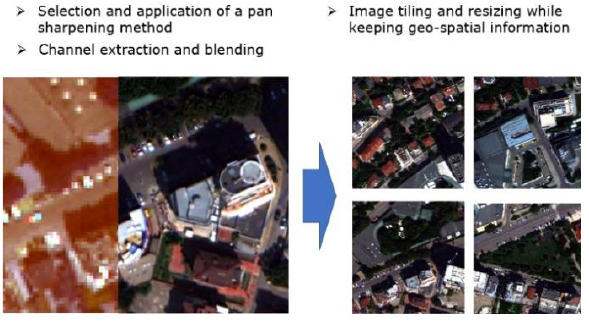
Figure 4. Image pre-processing.